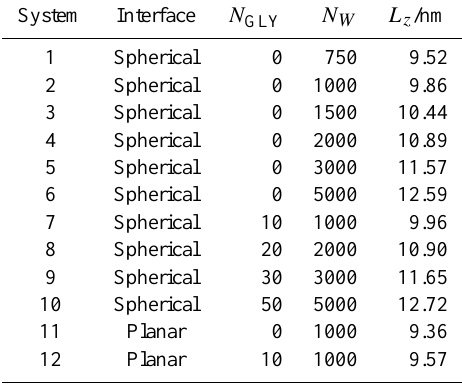
Table 1. Number of molecules and length of the box in the twelve systems. In systems 1–10 the interfaces are spherical and L z = L x = L y , while in systems 11–12 the interfaces are planar and L z =3 L x =3 L y